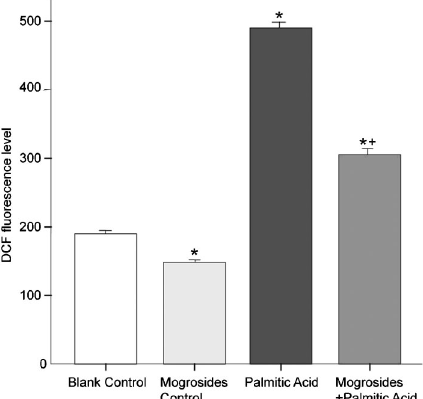
Figure 1. Comparison of intracellular reactive oxygen species (ROS) concentrations, shown as DCF fluorescence level, in different groups. Data are reported as means±SD for n=3. *P , 0.05, compared to the blank control group; + P , 0.05, compared to the palmitic acid group (one-way